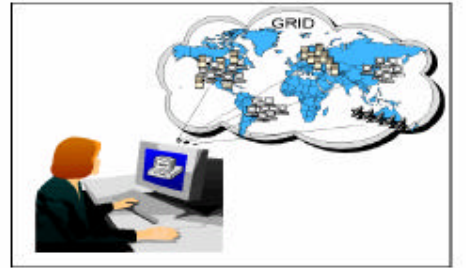
Figure 2: The Grid virtualizes herterogeneous and geographically disperse resource for each